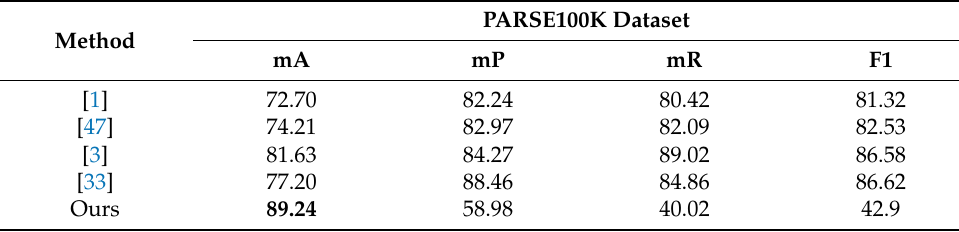
Table 8. Comparison with the state-of-the-art methods on the PARS100K